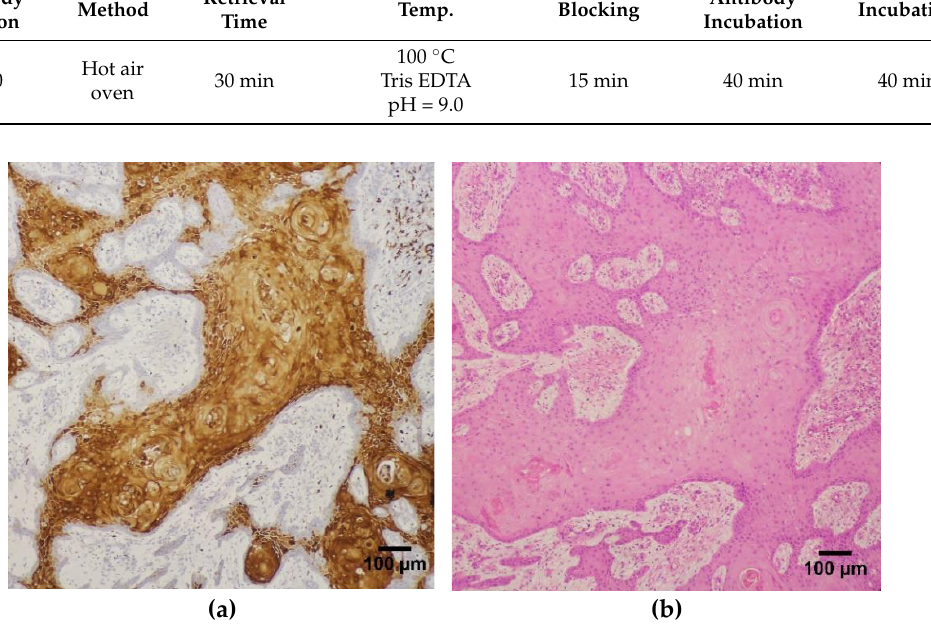
Figure 1. Photomicrographs of consecutive sections of SCC of the buccal mucosa showing sheets of tumor cell population. ( a ) IHC for HIF-1- α immunopositivity with minimal background staining using the final IHC parameters derived from the antibody optimization protocol (magnification × 100). ( b ) Corresponding Hematoxylin and Eosin stained section. 100 × magnification, scale bar represents 100